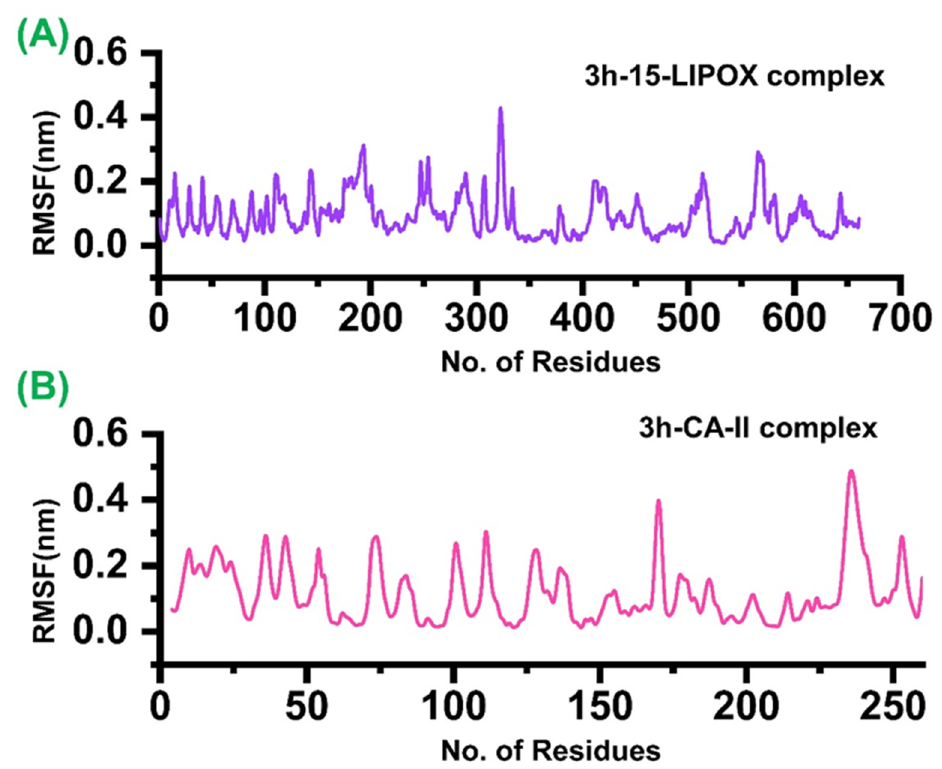
Figure 6. The residual flexibility of the ligand bound two complexes. ( A ) The RMSF of the 3h bound to 15-LOX; ( B ) the RMSF of the 3h when bound to b -CA II. The x-axis shows the total number residues while the y-axis shows RMSF in nm.